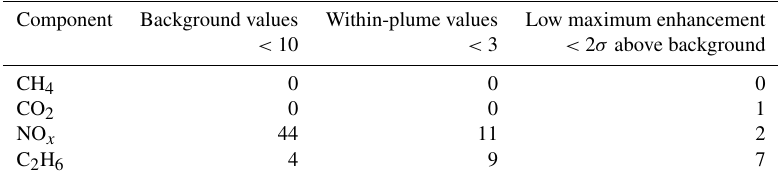
Table A2. Reasons for plume exclusion. See Sect. 2.3 for detailed criteria descriptions. Note that plumes could be excluded based on failing multiple criteria.